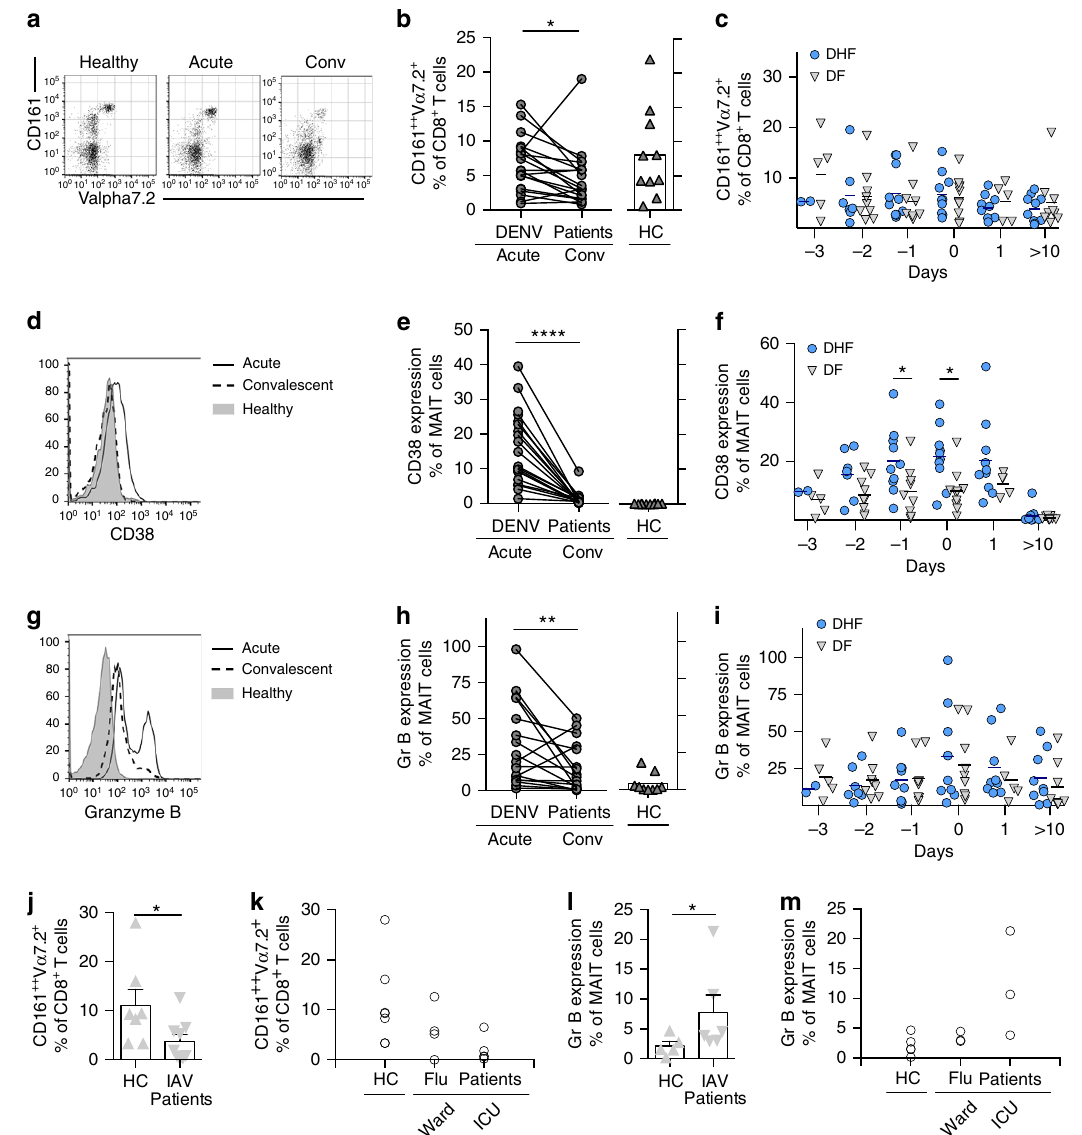
Figure 1 | MAITcell activation during acute viral infections in vivo. PBMC’s from healthy controls (HC, n ¼ 5–10), patients suffering from severe dengue (DHF, n ¼ 2–10), dengue (DF, n ¼ 4–10) or acute, hospitalized patients infected with influenza A virus ( n ¼ 7–9) were analysed by flow cytometry by gating on live CD3 þ CD8 þ CD161 þ þ V a 7.2 þ (MAIT) cells. ( a , d , g ) Representative flow cytometry plots. ( b , e , h ) Comparison between acute (day 0) and convalescent phase (day 4 10) of infection. ( c , f , i ) Comparison between DHFand DF patients. ( j – m ) Acute, hospitalized patients infected with influenza virus. ( b , c , j , k ) MAITcell frequency as a proportion of the CD8 þ Tcell population. ( e , f ) Percentage of CD38 expression by MAITcells. ( h , i , l , m ) Percentage of Granzyme B expression by MAIT cells. Statistical significance was determined with a Wilcoxon matched-paired test ( b , e , h ) or Mann–Whitney test ( j , k ). Bars represent means ± s.e.m. ns 4 0.05, * P 0.05, ** P r 0.01, *** P r 0.001, **** P r 0.0001. conv, convalescent; Gr B, Granzyme B; HC, healthy control; ICU, intensive care